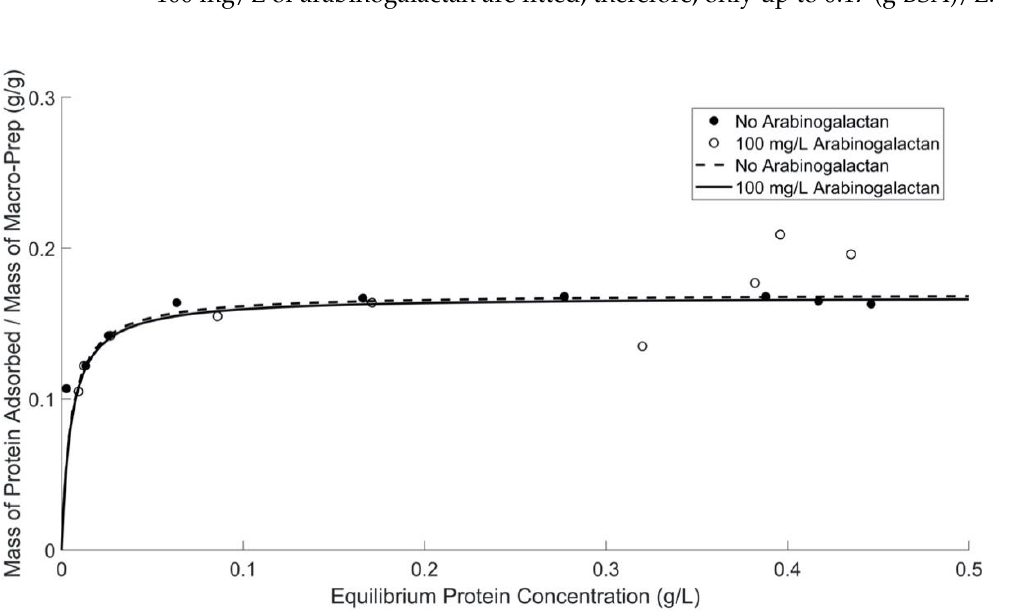
Figure 6. Macro-Prep ® ’s protein adsorption ability in model wine solutions with and without the addition of arabinogalactan (AG) by using the Bradford protein assay and a UV-Vis spectrometer at 595 nm. Data for 100 mg/L of arabinogalactan are fitted only up to 0.17 (g BSA)/L. Table 6. Effect of prototypical polysaccharide on protein adsorption. The Langmuir isotherm pa- rameters in the presence of arabinogalactan are estimated for low protein equilibrium concentra- tions.